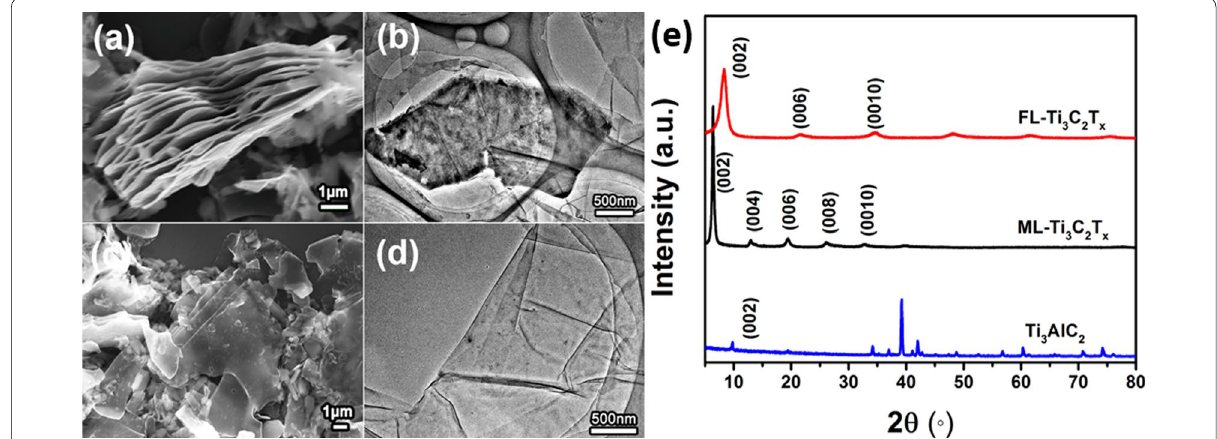
Fig. 1 Morphology and phase determinations. a , b SEM and TEM images of ML‑Ti 3 C 2 T x . c , d SEM and TEM images of FL‑Ti 3 C 2 T x . e XRD patterns of Ti